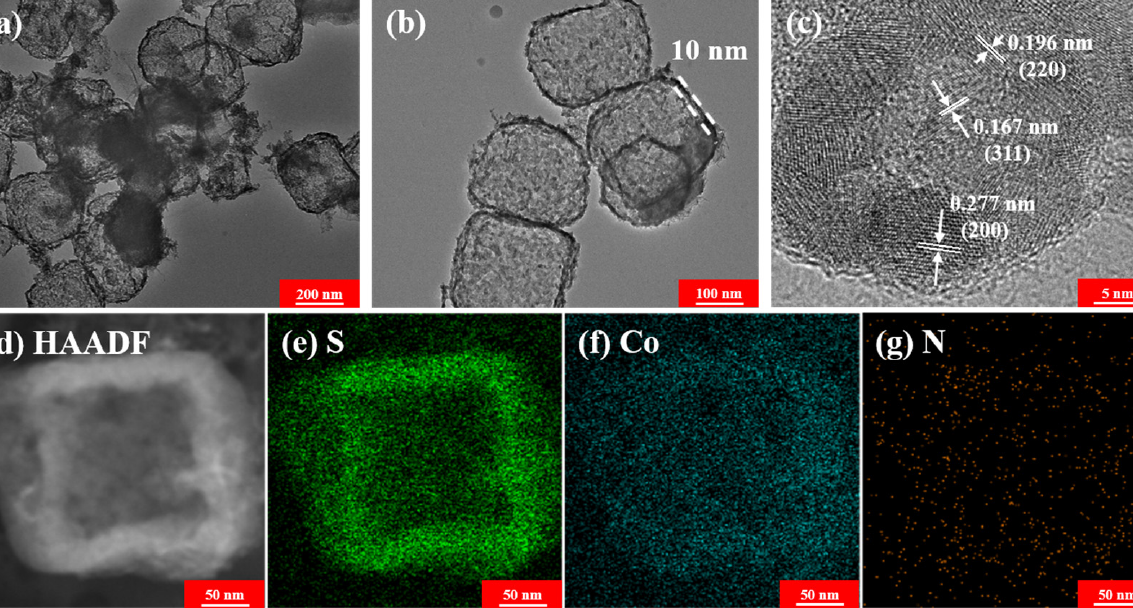
Figure 5. TEM images ( a , b ), HRTEM image ( c ), HAADF image and the element distribution maps of the CoS 2 hollow nanoboxes ( d – g ).